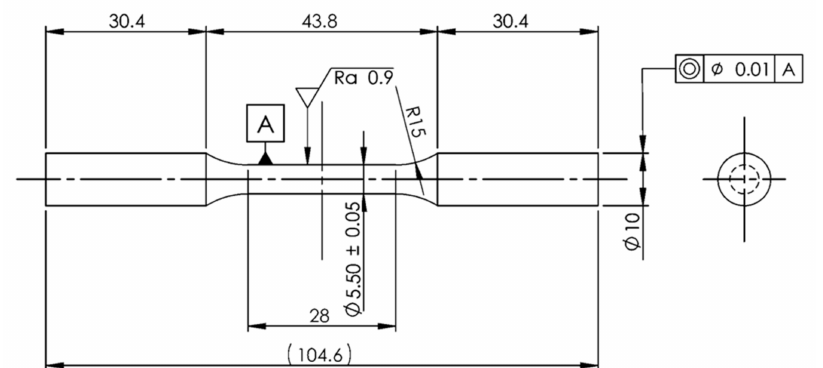
Figure 5. Geometry of plain cylindrical specimens tested under strain-controlled fatigue loading (dimensions are in mm). Specimens have been taken from the axle (see Figure 1 and region 2 of Figure 2), and after that, the cylindrical surface has been machined (Ra = 0.9 µ m). To investigate the detrimental effect of the casting skin, strain-controlled fatigue tests have been performed again under total strain control mode on plain flat specimens with three surfaces machined by milling to achieve a roughness of Ra = 0.4 µ m, while one has been kept as-cast (Figure 6). A nominal strain ratio R ε = − 1 has been adopted, and other testing parameters are kept the same as described above for cylindrical machined specimens.